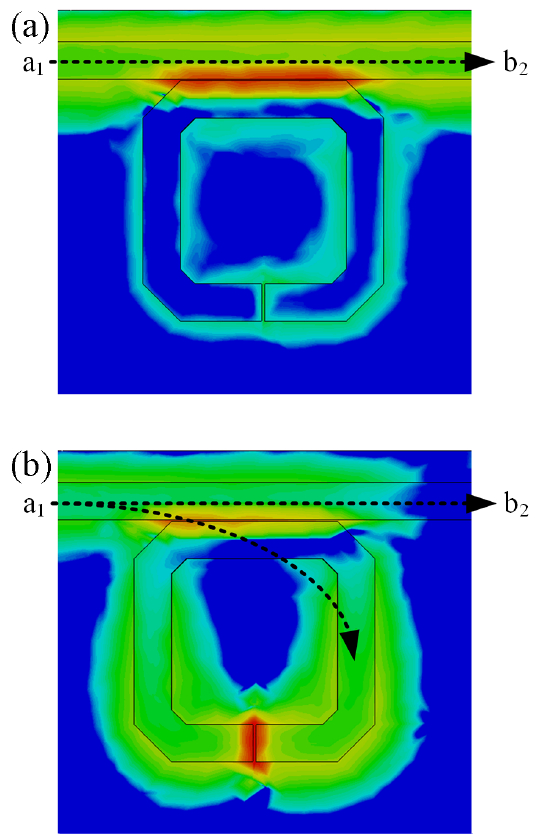
Figure 3. CST Microwave Studio simulation of the split-ring res- onator outside resonance (a) and in resonance (b)